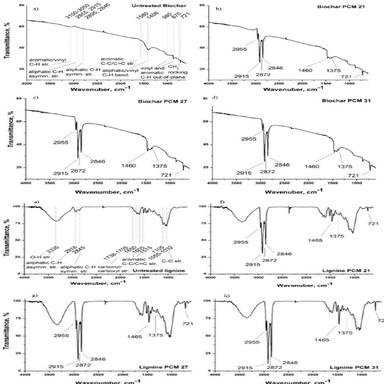
Full ATR-FTIR spectra of a) untreated biochar (or as is) and its mixtures with b) PCM 21, c) PCM 27, d)PCM 31, e) untreated lignin (or as is) and its mixtures with f) PCM 21, g) PCM 27, and h)PCM 31.